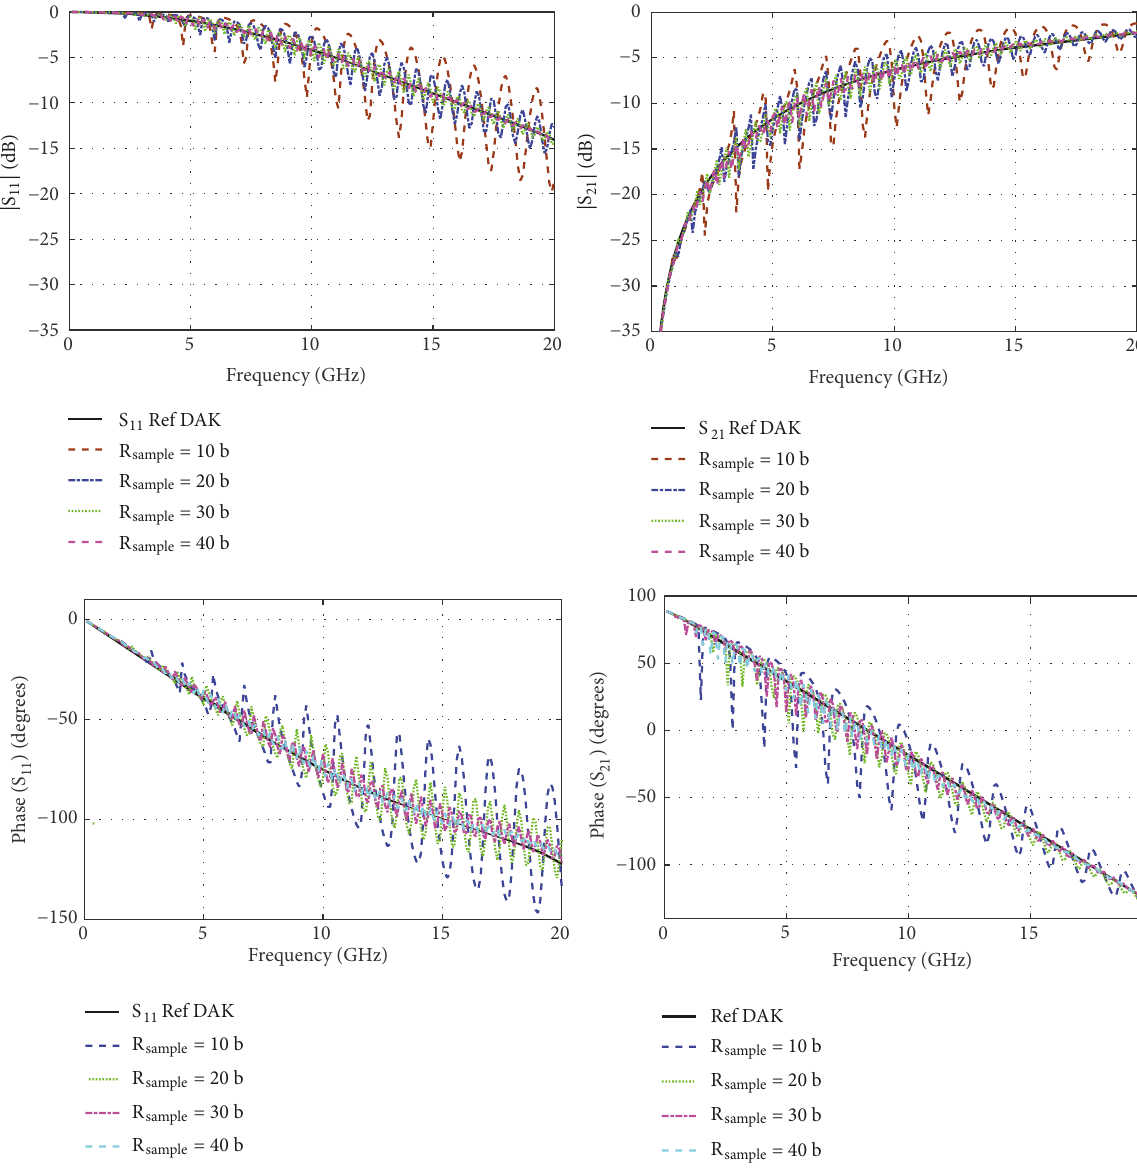
modes at the input/output coaxial lines, for n